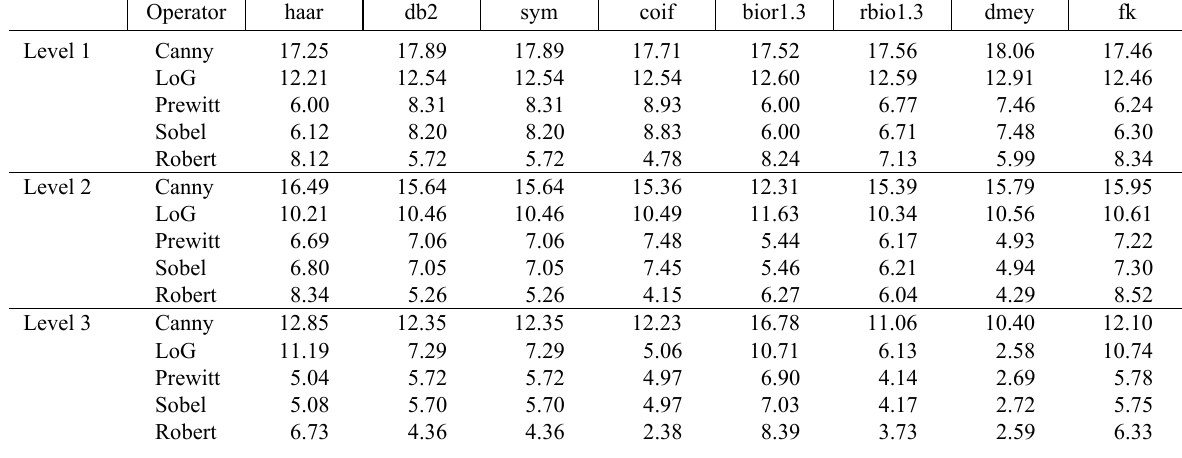
Table 7. PR values for different edge detection operators and wavelet transformations for an image with HD